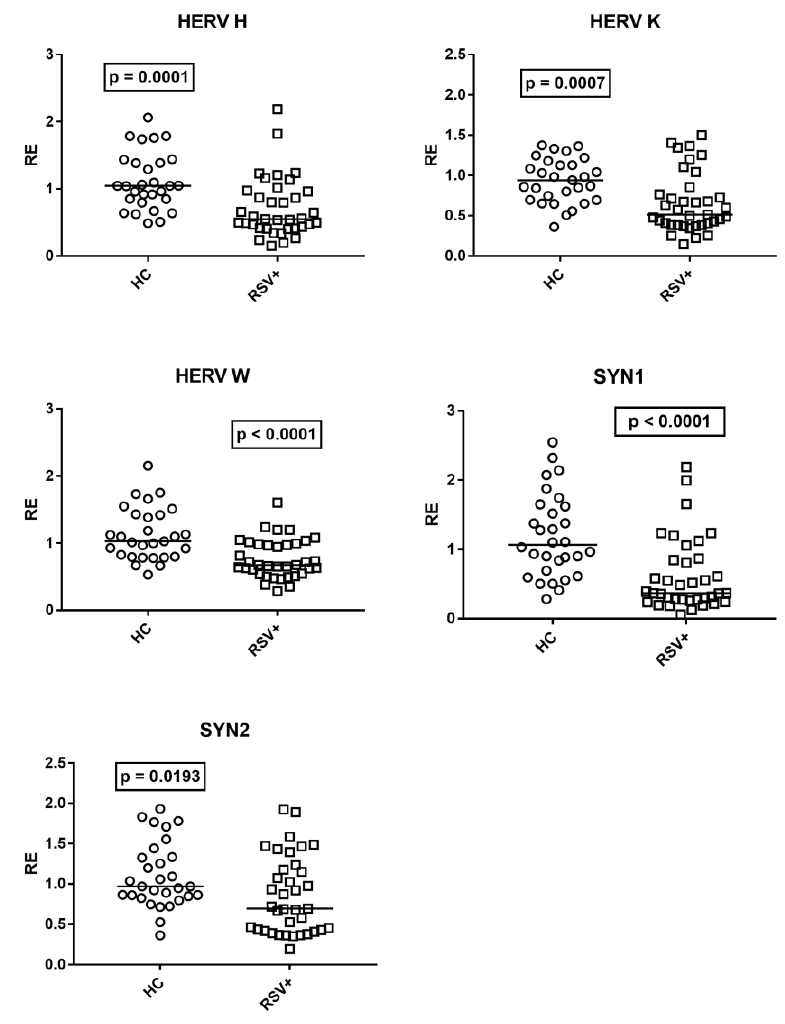
Figure 5. Transcription levels of pol genes of HERV-H, HERV-K, and HERV-W, and of env genes of syncytin (SYN)1 and syncytin (SYN)2 in whole blood from 37 children with acute RSV bronchiolitis (RSV+), from 29 healthy children (HC) for HERV-pols, and 30 HC for SYN1-env and SYN2-env. RE: relative expression. Circles and squares show the median of three individual measurements; horizontal lines show the median values. Median values and interquartile range 25–75%, HERV-H-pol: HC 1.05, 0.85–1.39; RSV+ 0.55, 0.42–0.96; HERV-K-pol: HC 0.94, 0.70–1.13; RSV+ 0.51, 0.39–0.77; HER-W-pol: HC 1.03, 0.80–1.42; RSV+ 0.67, 0.55–0.98; SYN 1-env: HC 1.07, 0.73–1.60; RSV+ 0.37, 0.28–0.85; SYN2-env: HC 0.97, 0.85–1.33; RSV+ 0.69, 0.43–1.18. Statistical analysis: Mann–Whitney test was used to compare values of each group of children with each